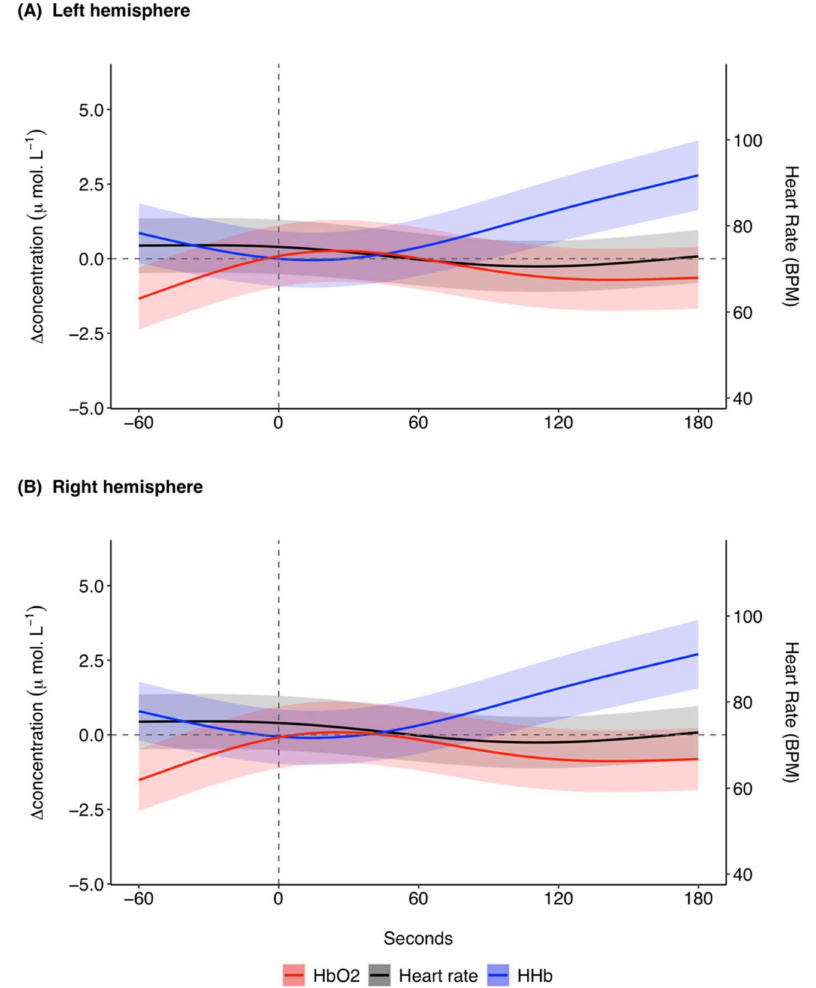
Figure 3. GAMM model prediction outcomes for [ ∆ HHb] ( µ mol L − 1 ), [ ∆ O 2 Hb] ( µ mol L − 1 ), and heart rate (BPM) in the ( A ) left hemisphere and ( B ) right hemisphere for 60 s before and 180 s after ketamine administration at time 0 s for 27 trials across five grey seals. For illustrative purposes a baseline shift was completed so that all concentrations are expressed as relative changes from a baseline (0 µ mol L − 1 ) between the left and right hemispheres at time of drug administration. Changes in heart rate are systemic, meaning the presented model prediction outcomes for heart rate are the same for the left and right hemispheres. The shaded regions represent the 95% confidence intervals. GAMM, generalised additive mixed model; [ ∆ HHb], change in concentration of deoxygenated haemoglobin; [ ∆ O 2 Hb], change in concentration of oxygenated